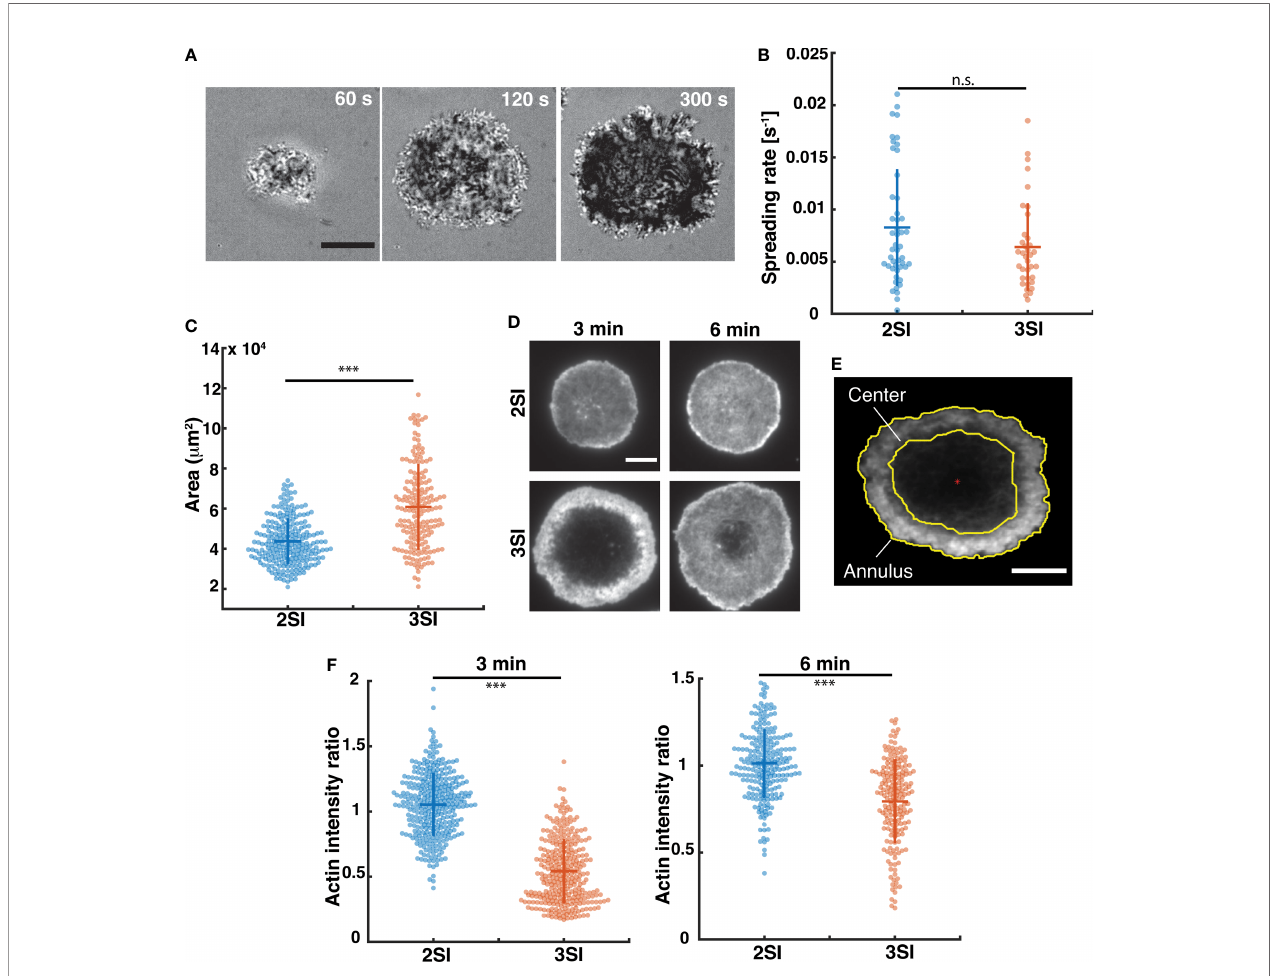
FIGURE 1 | Spreading kinetics and actin distribution in activated CTLs. (A) Representative time-lapse images of a 3SI CTL spreading on an anti-CD3-coated coverslip and imaged using IRM. Scale bar = 10 µm. (B) Spreading rates of 2SI (n=48 cells), 3SI (n=36 cells) CTLs from at least 3 independent experiments. (C) Representative TIRF images of 2SI and 3SI CTLs fi xed at 3 and 6 minutes and stained with phalloidin to visualize F-actin. (D) Immune synapse area obtained from TIRF images of phalloidin-stained 2SI and 3SI CTLs fi xed at 6 min. (E) Depiction of the erosion of a binary mask to de fi ne central and annular regions in the cell. Red asterisk indicates the cell centroid. (F) Actin intensity ratio at 3 and 6 min. Actin intensity ratio was de fi ned at the ratio of actin MFI at the center to the actin MFI at the annulus. Scale bar = 5 um for panels (D, E) . Data taken from at least 150 cells from 3 independent experiments. Wilcoxon rank-sum test performed to calculate p-values. ***p<0.001, n.s. - not signi fi